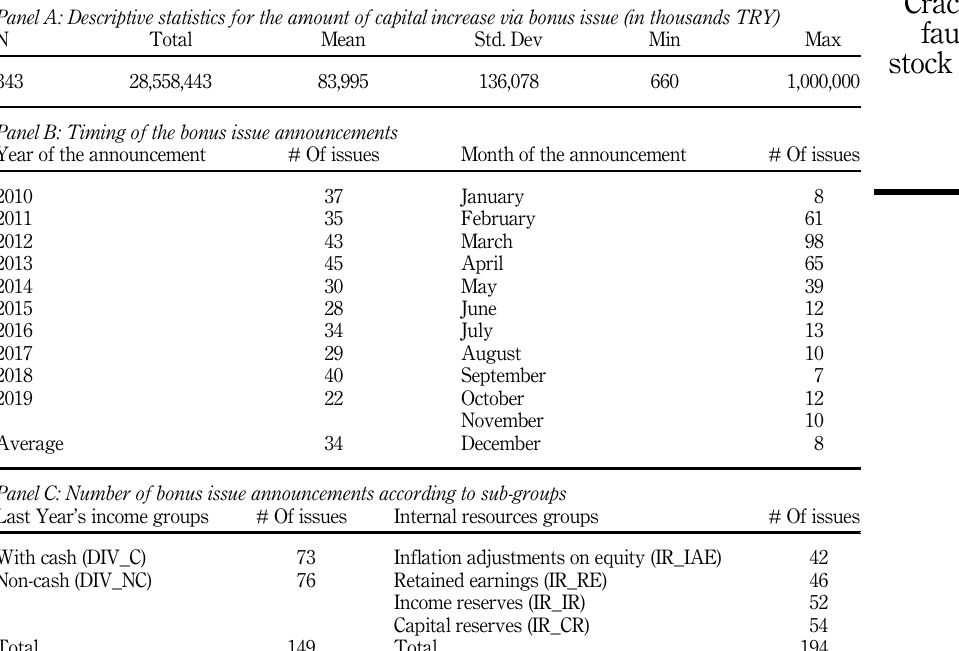
Panel D: Descriptive statistics for issue size groups Issue size groups